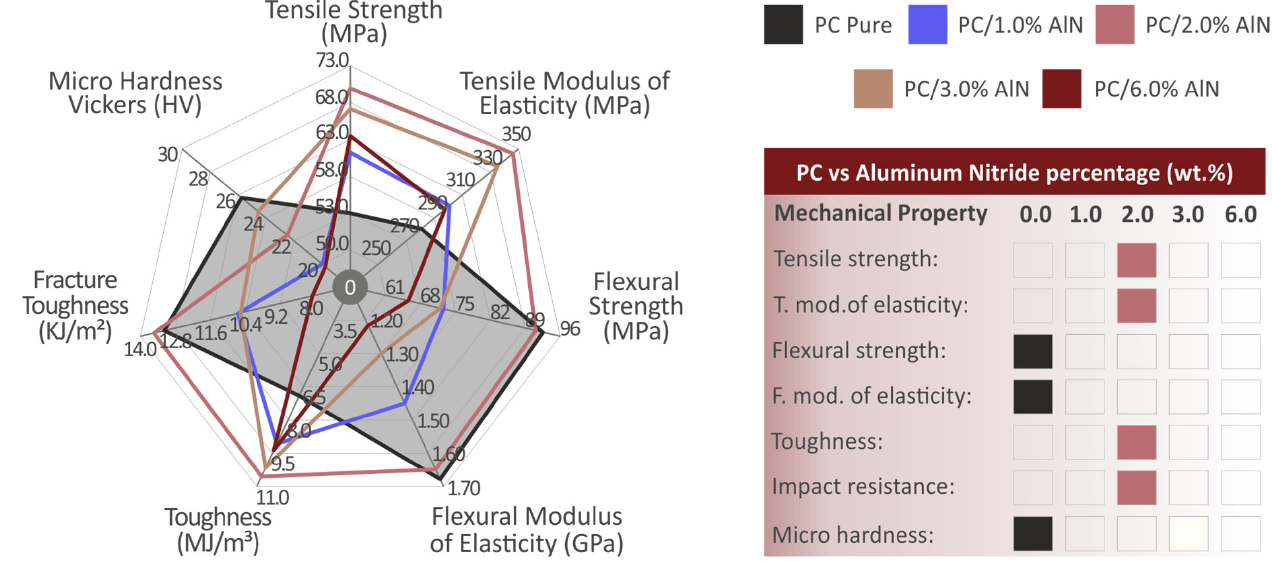
Figure 17. Summary of mechanical test results, depicted in a spider diagram. The shaded area corresponds to the pure PC. The right table presents the materials with the highest performance for each mechanical test.